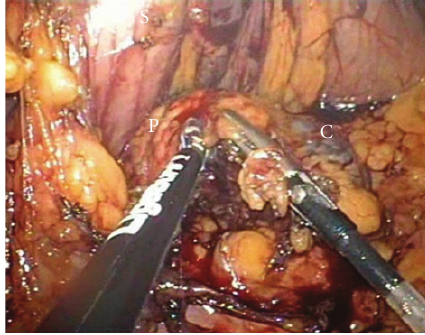
Figure 4: Transection of pancreatic neck using ligasure and rotic- ulator endograsper.